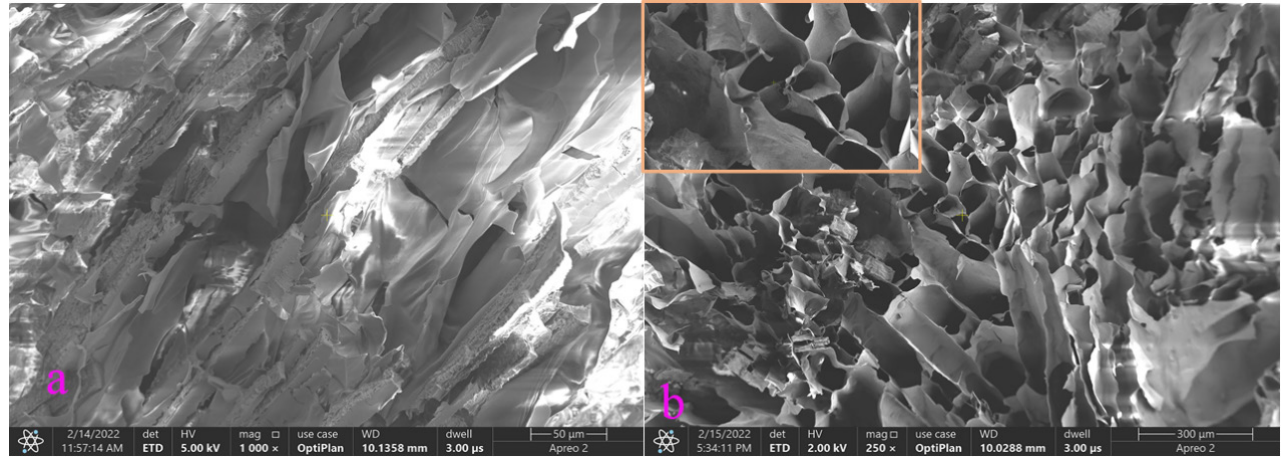
Figure 6. Irregular arrangement of CMCS blank gels (a) and regular arrangement of CMCS/EVA co-mixture gels (b) in SEM images.